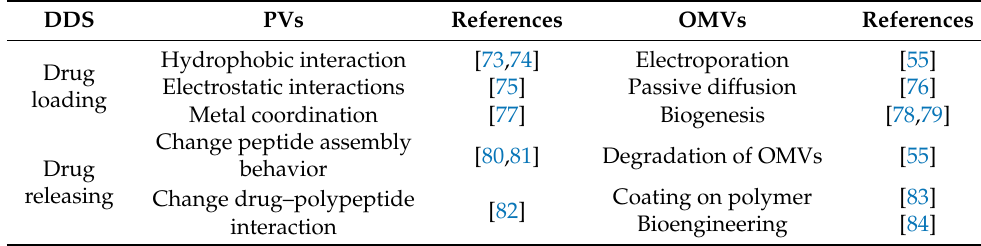
Table 2. Comparison of drug loading and releasing by PVs and